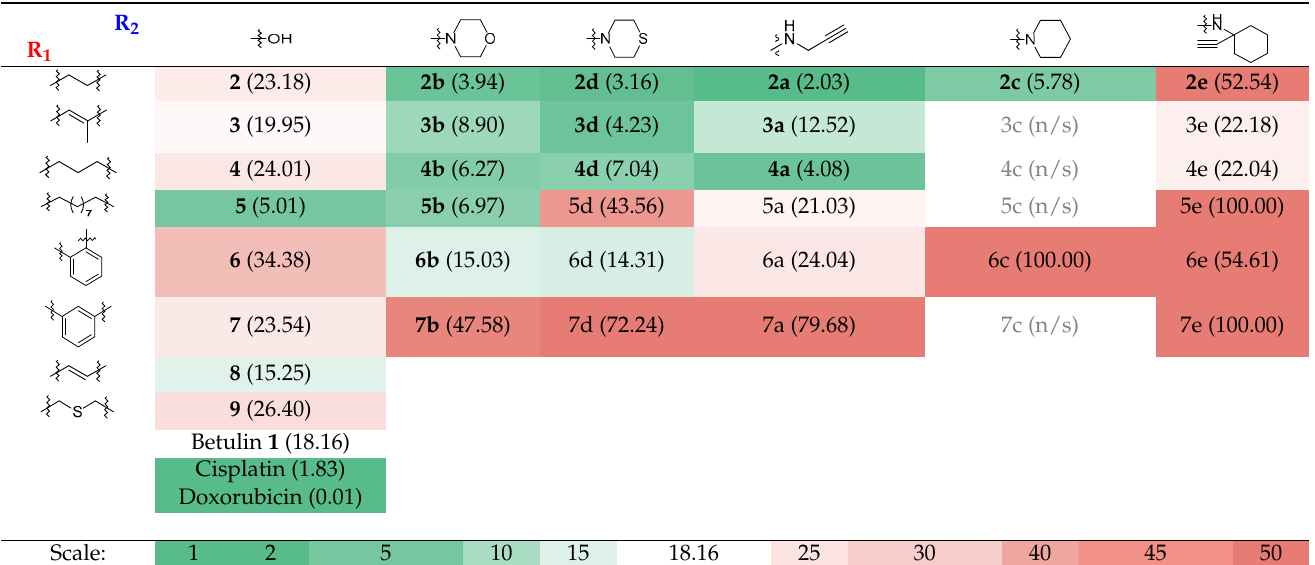
Table 1. Growth inhibition (IC 50 , µM) efficiency of reference compounds (betulin 1 , cisplatin and doxorubicin) and betulin derivatives on leukemia cell line; n/s-not studied due to insolubility in DMSO.